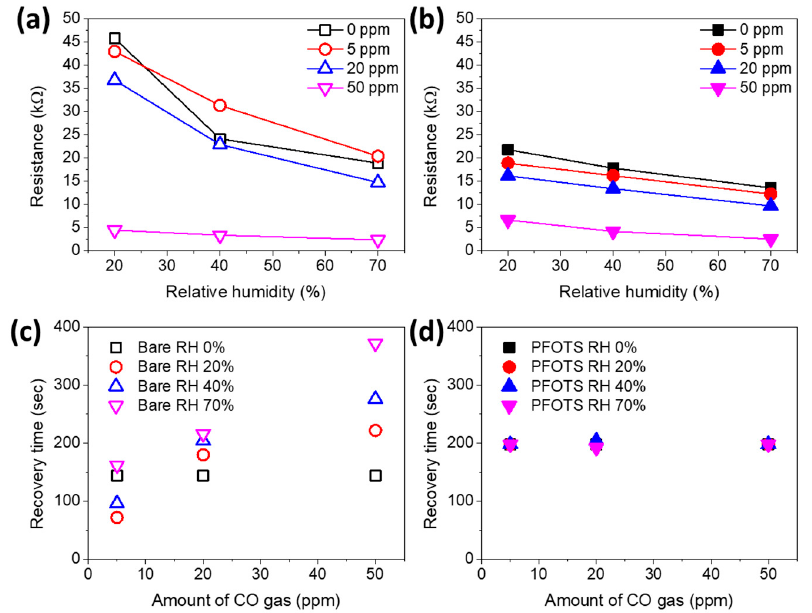
Figure 5. The resistance values ( a , b ) and recovery times ( c , d ) of both bare and PFOTS coated porous SnO 2 film gas sensor according to different relative humidity and amount of CO gas.